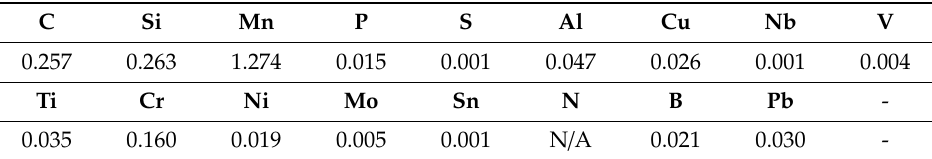
Table 4. Chemical composition (wt %) of the 22MnB5-GA.